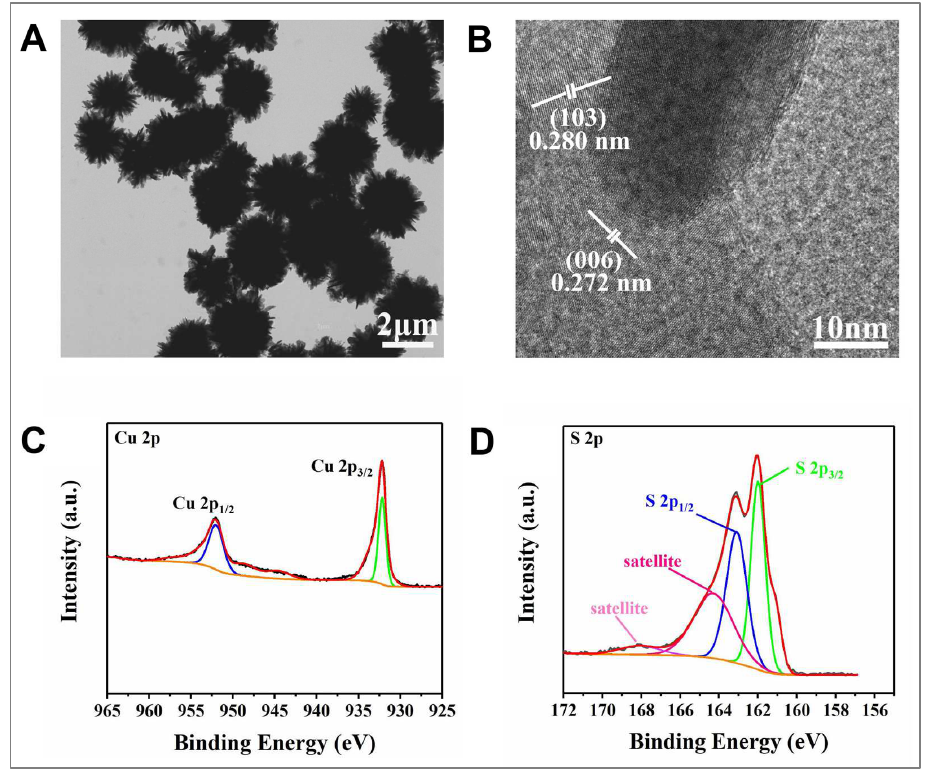
Figure 1. The TEM ( A ) and high resolution TEM ( B ) graph of the prepared CuS nanomaterial; The high resolution XPS spectrum of Cu 2p ( C ) and S 2p ( D ). high resolution XPS spectrum of Cu 2p ( C ) and S 2p ( D